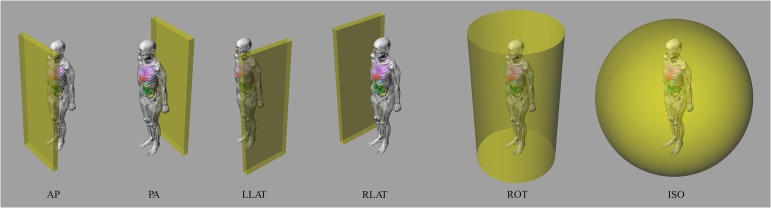
The relative position of the source and phantom in various irradiation geometries. AP = anterior–posterior irradiation, PA = posterior–anterior irradiation, LLAT and RLAT = left and right lateral axes irradiation, ROT = rotational directions around the phantom irradiation, ISO = fully isotropic irradiation.